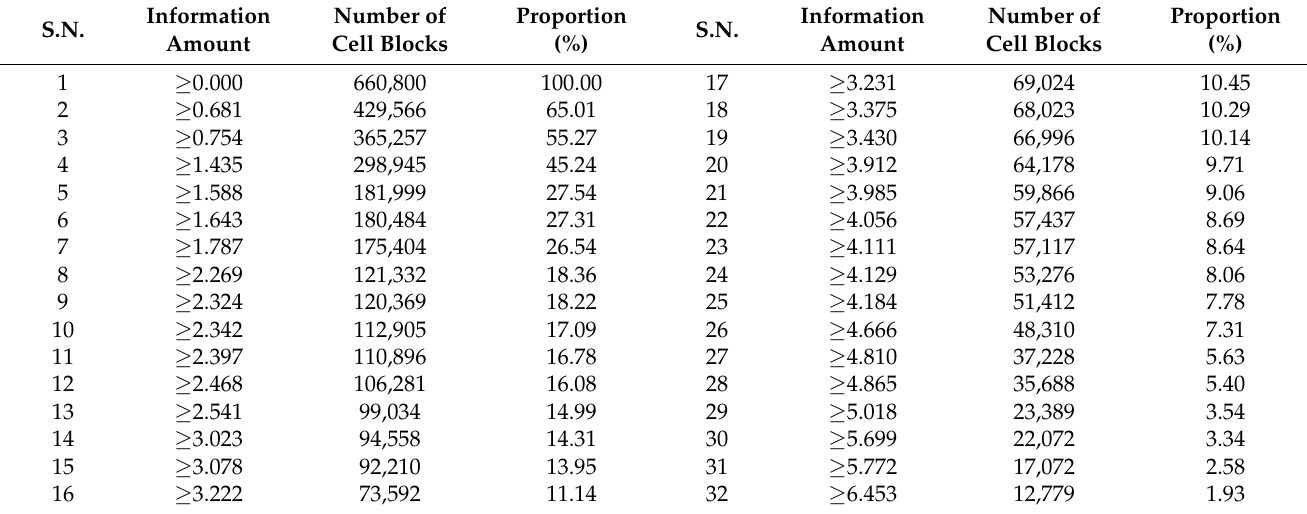
Table 2. Proportion of metallogenic information amount intervals of cell blocks of the Jiaojia